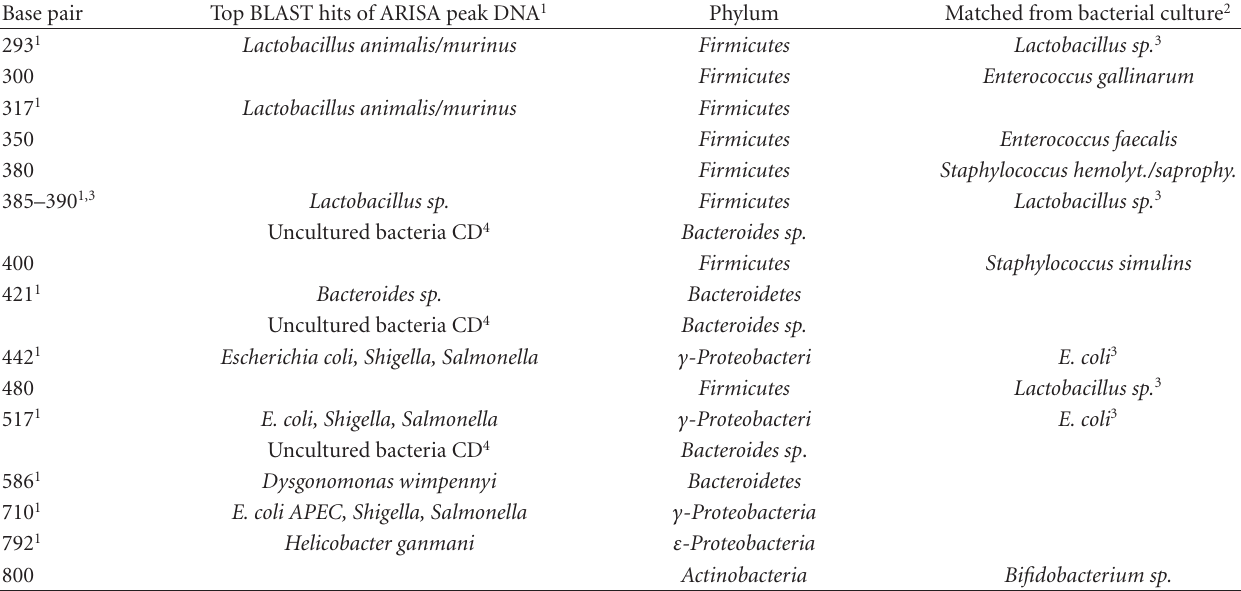
Table 2: Identification of ARISA peak